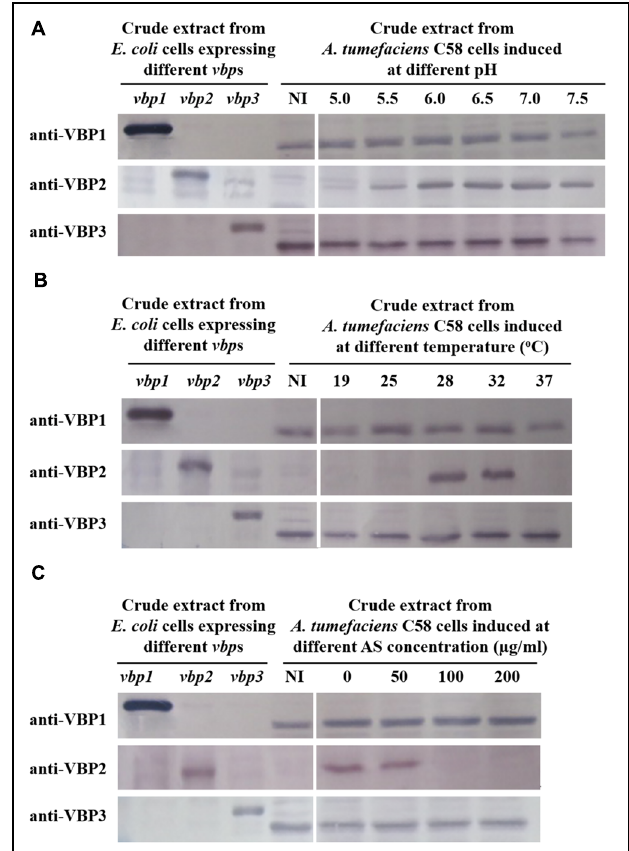
FIGURE 2 | Expression of three vbp genes in Agrobacterium tumefaciens strain C58 at different pHs (A), temperatures (B) and AS concentrations (C). A. tumefaciens strain C58 cells were induced under the indicated pH, temperature or AS concentration. Crude extracts from the differentially induced C58 cells were separated using SDS-PAGE and then analyzed by Western blotting. Crude extracts from E. coli cells expressing different vbp genes with His-tag were used as positive controls. The anti bodies used in this study are listed on the left. NI: crude extracts from C58 cells not induced in IB medium. (A) Effect of pH on the expression of vbp s in A. tumefaciens C58. The temperature is 25 ◦ C and AS concen tration is 100 µ g/ml. (B) Effect of temperature on the expression of vbp s in A. tumefaciens C58. The pH is 5.5 and AS concentration is 100 µ g/ml. (C) Effect of AS concentration on the expression of vbp s in A. tumefaciens C58. The pH is 5.5 and temperature is 25 ◦ C. Some differences in protein size of E. coli recombinant VBP2 protein (the positive control band in panel C immigrated faster than that in other panels) are likely attributable to prolonged